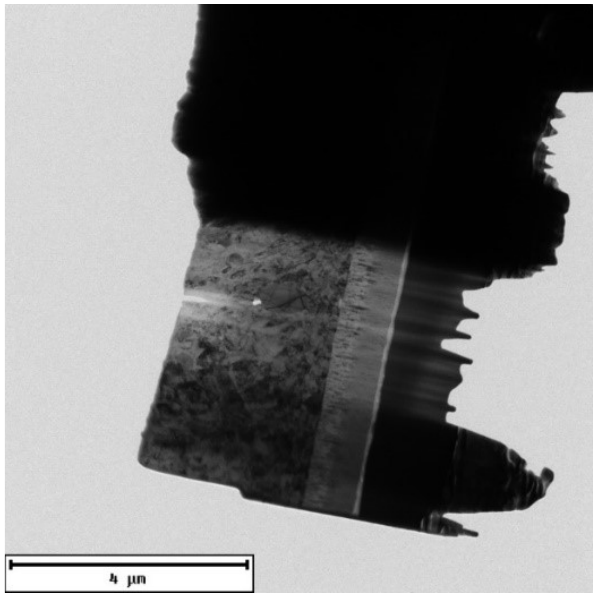
Figure 5. Overview of the lamella.